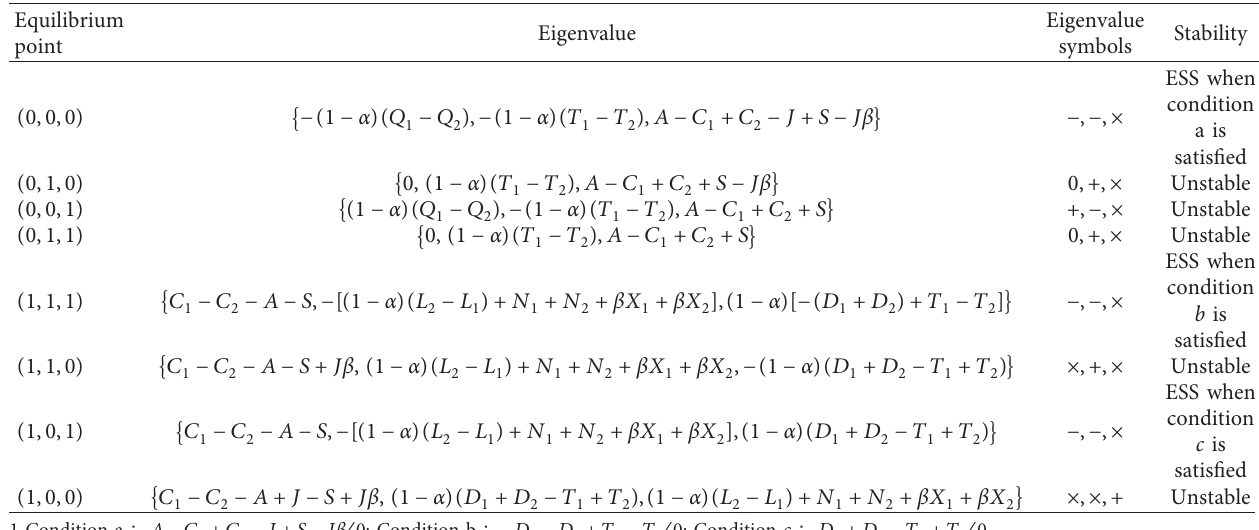
Figure 4: Phase diagram of e-commerce platform strategy Table 3: Replicated dynamic system equilibrium point asymptotic stability analysis.